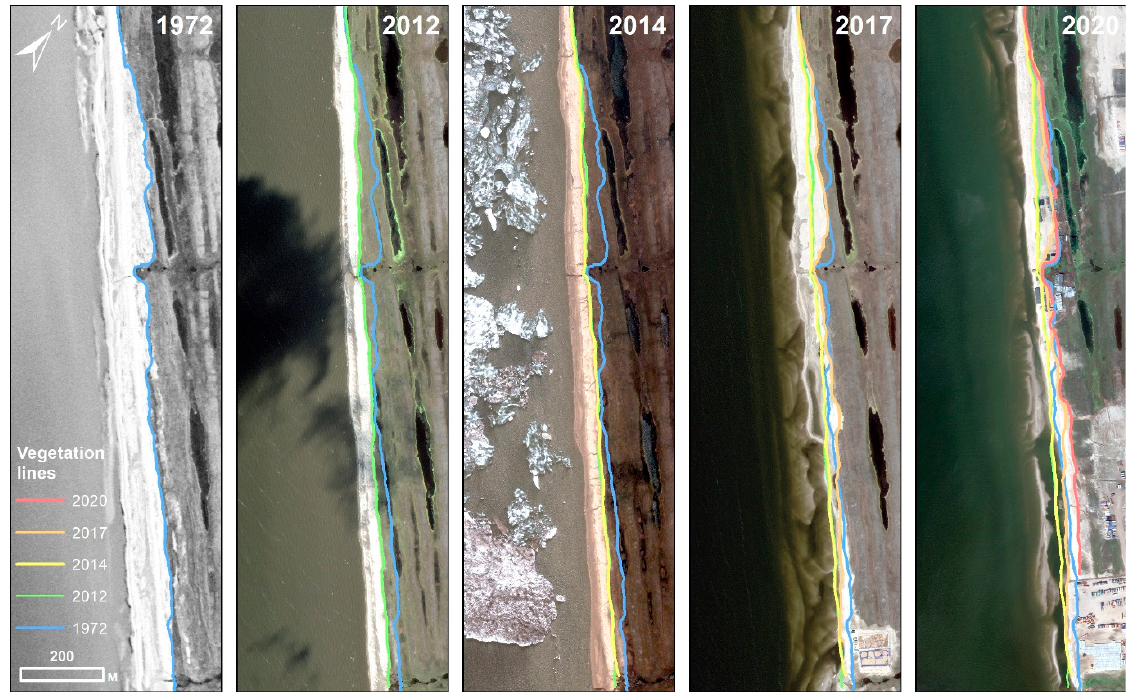
Figure 6. Vegetation line position changes from 1972 to 2020 in the area with the highest rates of retreat. 2012–2014. The years of 2012–2014 was a period of relatively stable dynamics with dominating accumulation (advancing of the shoreline and vegetation line). About 3/4 (77%) of the shoreline and about 1/3 (34%, which is the greater part) of the vegetation line shifted seawards. The shoreline advanced at an average rate of 4.1 m/yr and a maximal rate of 21.6 m/yr in the SE area close to the Nadyaipingche River mouth. In the central